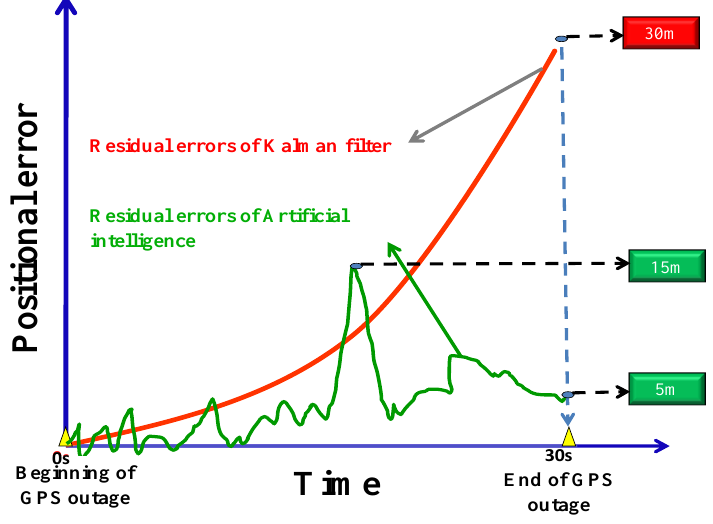
Figure 5. The error behavior of artificial intelligent models during GPS